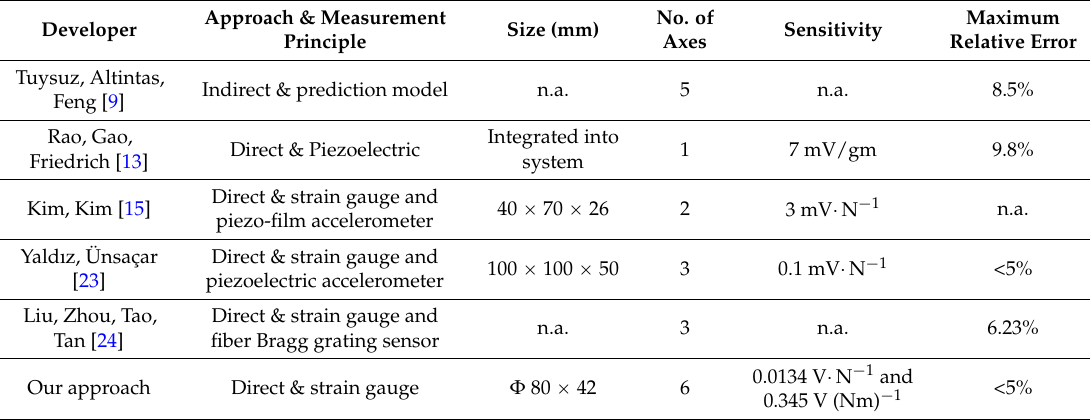
Table 7. The performance comparisons with some proven reference sensors.